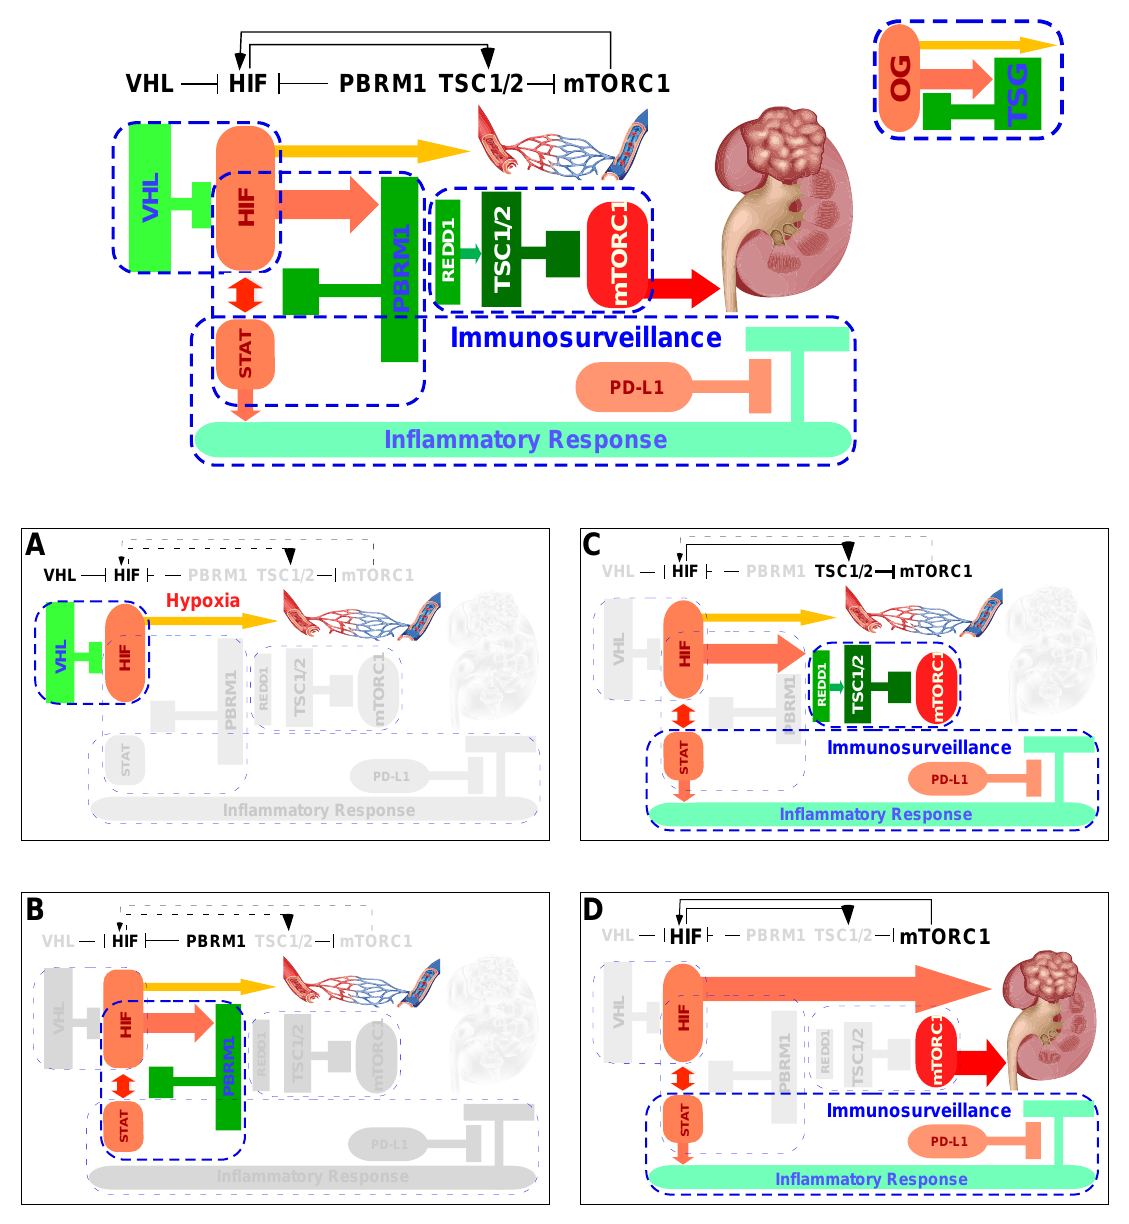
FIGURE 1: The interconnected OG-TSG CBs operate in renal epithelium to control signaling output and prevent tumorigenesis. (A) Depicts the physiological employment of the inherent VHL-HIF CB to gauge tissue response to low oxygen tension, and (B-D) examine how the se- quential losses of a pre- determined set of “OG - TSG CBs” once the first CB is inactivated result in